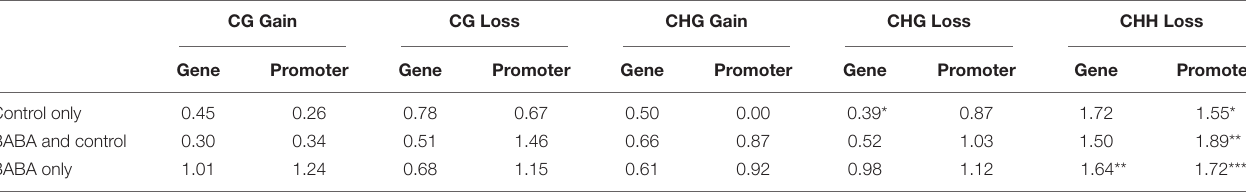
Figures show the enrichment of DMRs in DEG lists (proportion of genes in the DEG list containing DMRs relative to the proportion of genes with DMRs in the whole genome). Enrichment was calculated separately for hypermethylation (gain) and hypomethylation (loss) in CG, CHG, and CHH methylation contexts in the transcribed region (Gene) and promoter region of each gene. Asterisks represent statistical significance (*P < 0.05, **P < 0.01, ***P < 0.001 by Fisher’s exact test).